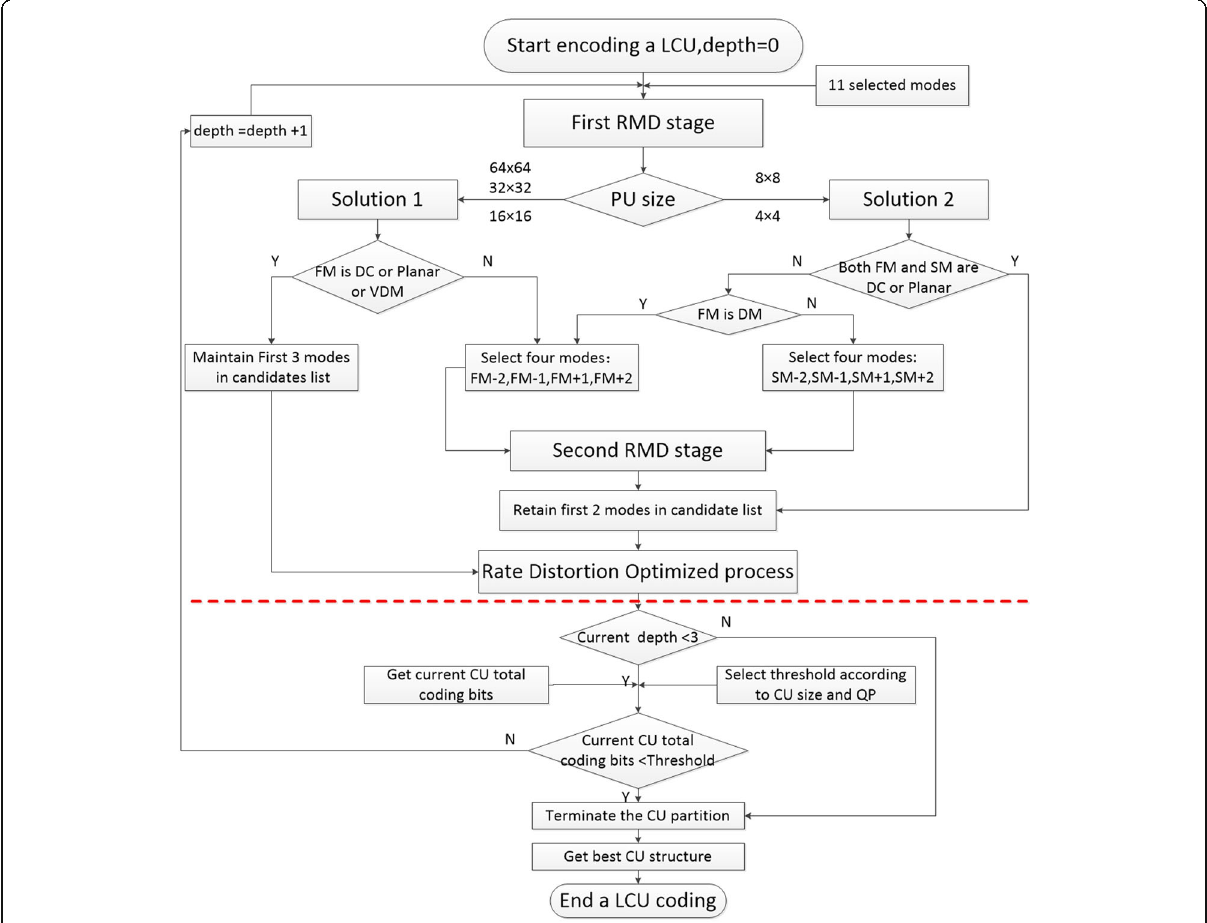
Fig. 5 Architecture of proposed algorithm. FM is the first mode in candidate list, SM is the second mode in candidate list, DM is the directional mode, and VDM is the vertical direction